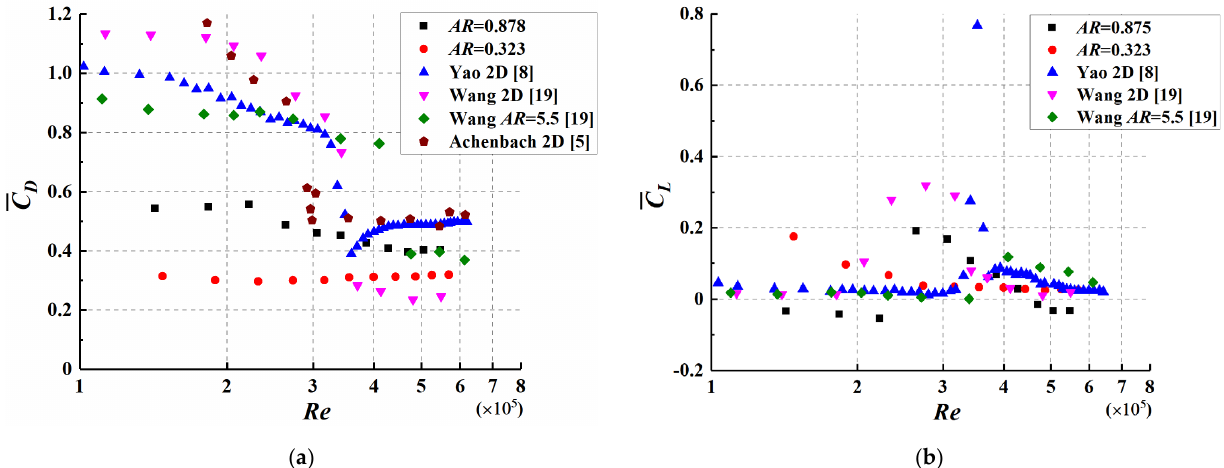
Figure 11. The comparison of the mean local force coefficient of circular cylinders in the smooth flow. ( a ) The mean local drag coefficient; ( b ) The mean local lift